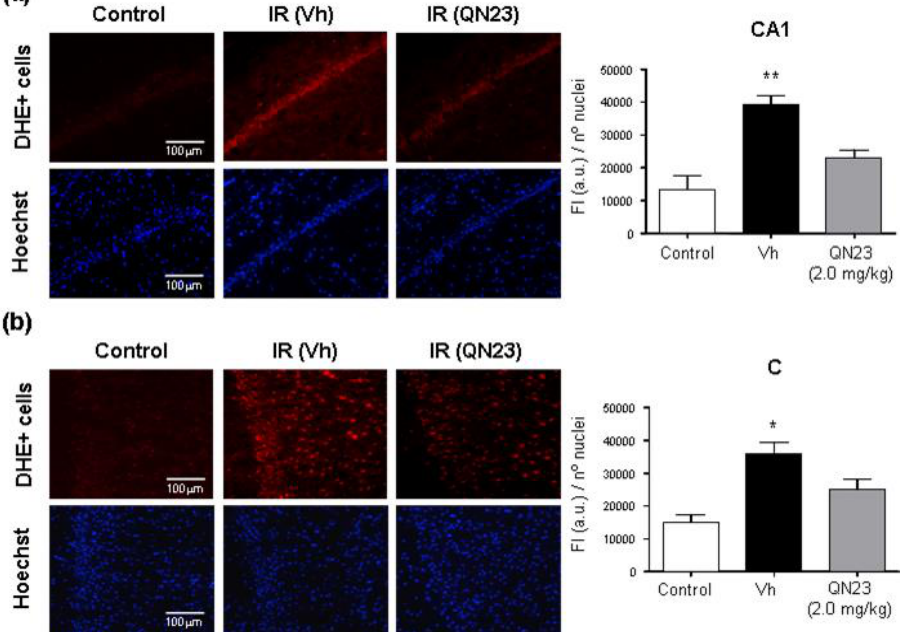
Figure 3. Antioxidant capacity of QN23 in vivo. Ischemic animals were treated with QN23 (2.0 mg/kg) or vehicle (Vh) by intravenous injection at the onset of reperfusion after cerebral ischemia (IR), dihydroethidium (DHE, 3.0 mg/kg) was injected intravenously at 2 h after reperfusion, and the animals were euthanized at 4 h after DHE injection. Control animals were also injected with DHE and euthanized 4 h after injection. The antioxidant effect of QN23 was studied by quantifica- tion of fluorescence intensity of ROS-reacted DHE in brain sections. Representative images of cells stained with ROS-reacted DHE (DHE+ cells) in the hippocampal CA1 ( a ) and cortical ( b ) regions. Bar graphs represent the fluorescence intensity (FI) quantified in brain sections from control, vehicle-, and QN23-treated animals injected with DHE in the hippocampal CA1 (CA1) and cortical (C) regions. Data represent the mean of 3–5 independent animals per group (3 control animals, 5 animals treated with vehicle, and 4 treated with QN23); error bars indicate the SE. * p < 0.05 and ** p < 0.01, compared with the control or QN23-treated group by Newman–Keuls’ post-test after ANOVA. FI is expressed in arbitrary units